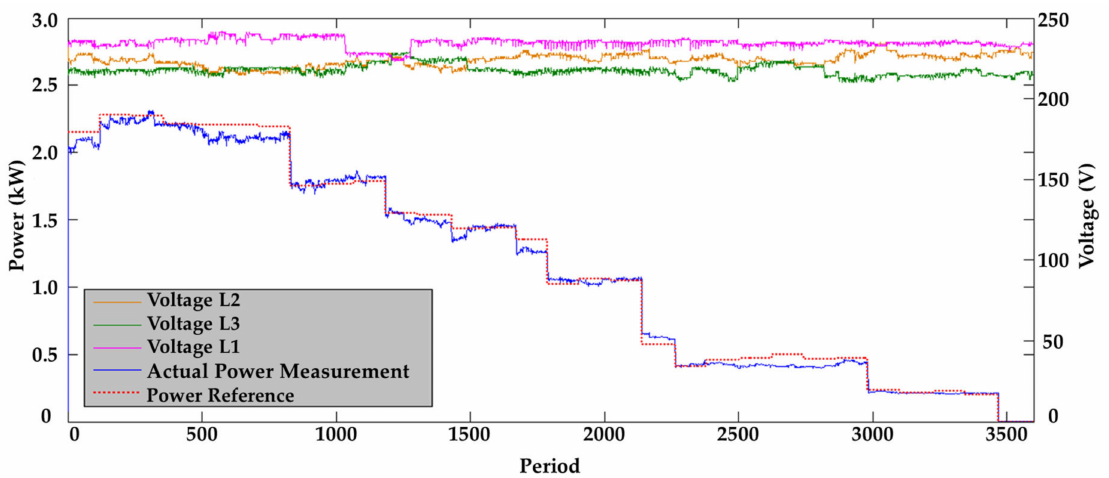
Figure 11. Experimental results adapted from OP5600 and Resistive Loads